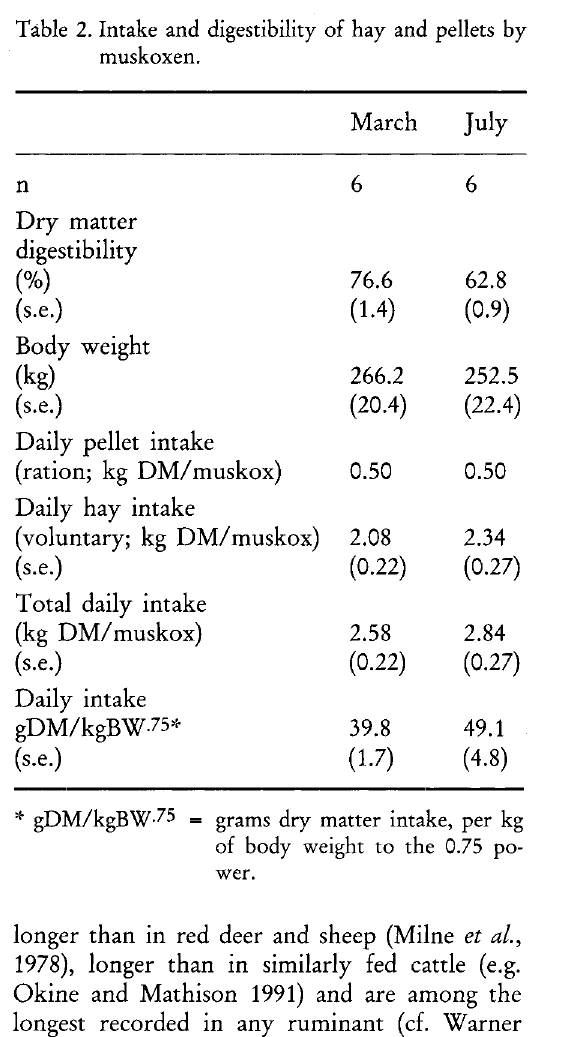
Table 2. Intake and digestibility of hay and pellets by